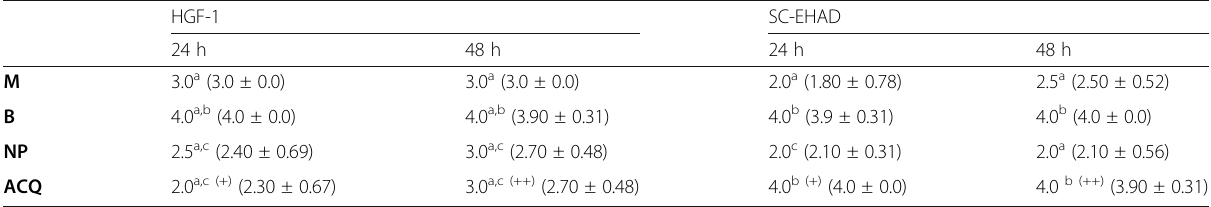
Table 3 Adhesion (24 h) and proliferation (48 h) index of HGF-1 and SC-EHAD cells at the different surfaces [median (mean ± standard-deviation)]